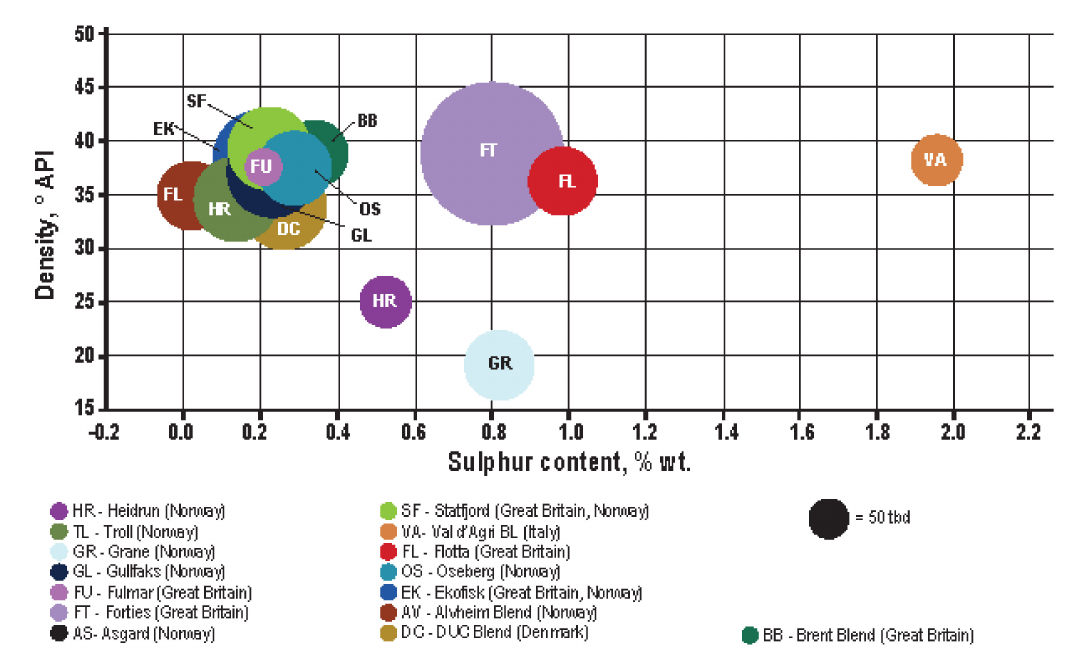
Figure 17. Quantity and quality of Western European oil [74]. Table 9. The content of metals and sulfur in various grades of commercial oils of Western Europe [75].